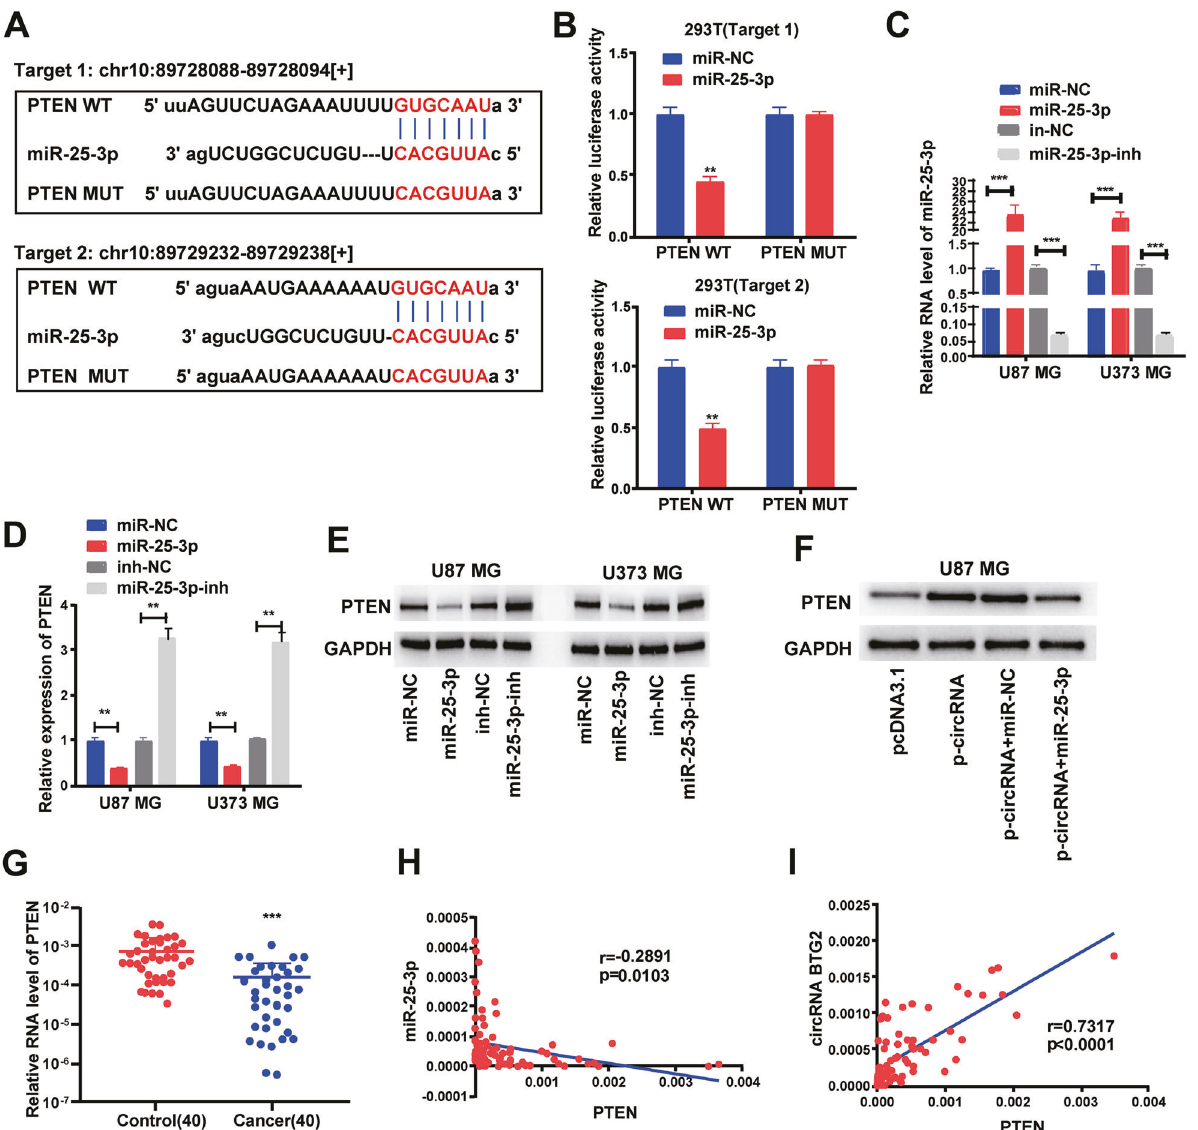
Fig. 6 circRNA BTG2/ miR-25-3p axis is critical for PTEN expression. A Bioinformatics analysis revealed the predicted binding sites between PTEN and miR-25-3p. B Luciferase reporter assay demonstrated miR-25-3p mimics signi fi cantly decreased the luciferase activity of PTEN-WT in HEK293T cells. C The transfection ef fi ciency of miR-25-3p mimics and inhibitor in U87 MG and U373 MG cells. D , E The mRNA ( D ) and protein ( E ) level of PTEN was detected through qRT-PCR and western blotting after transfection with miR-25-3p mimics and inhibitor in U87 MG and U373 MG cells. F circRNA BTG2 overexpression upregulated PTEN, this effect can be reversed by co-transfection with miR-25-3p mimics in U87 MG cells. G The expression levels of PTEN in 40 glioma tissues and matched para-carcinoma normal tissues was determined by qRT-PCR. H Expression levels of PTEN negatively correlated with miR-25-3p in glioma tissues. I Expression levels of PTEN positively correlated with circRNA BTG2 in glioma tissues. ** P < 0.01 and *** P < 0.001 for statistical